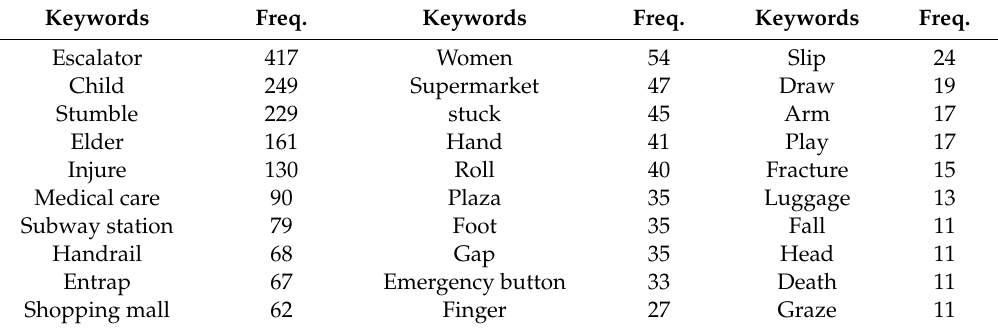
Table 2. High-frequency keywords of EIs news